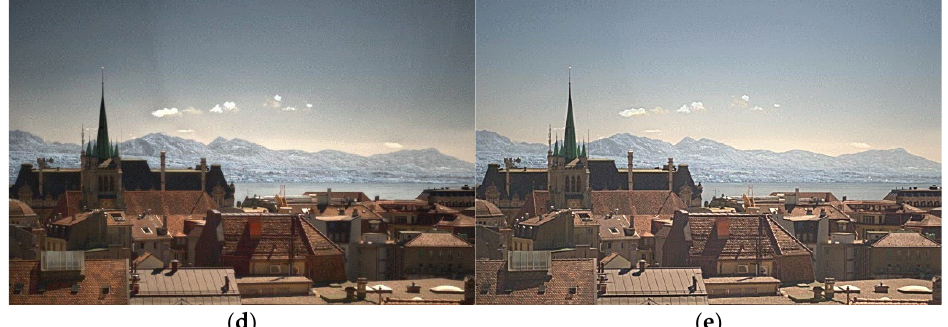
Figure 13. Daytime input and result images (1): ( a ) visible-light image and near-infrared image, ( b ) Densefuse method result, ( c ) Vanmali method result, ( d ) PCA method result, ( e ) proposed method result.